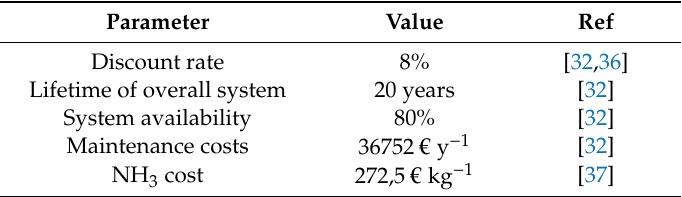
Table 7. LCOE constant